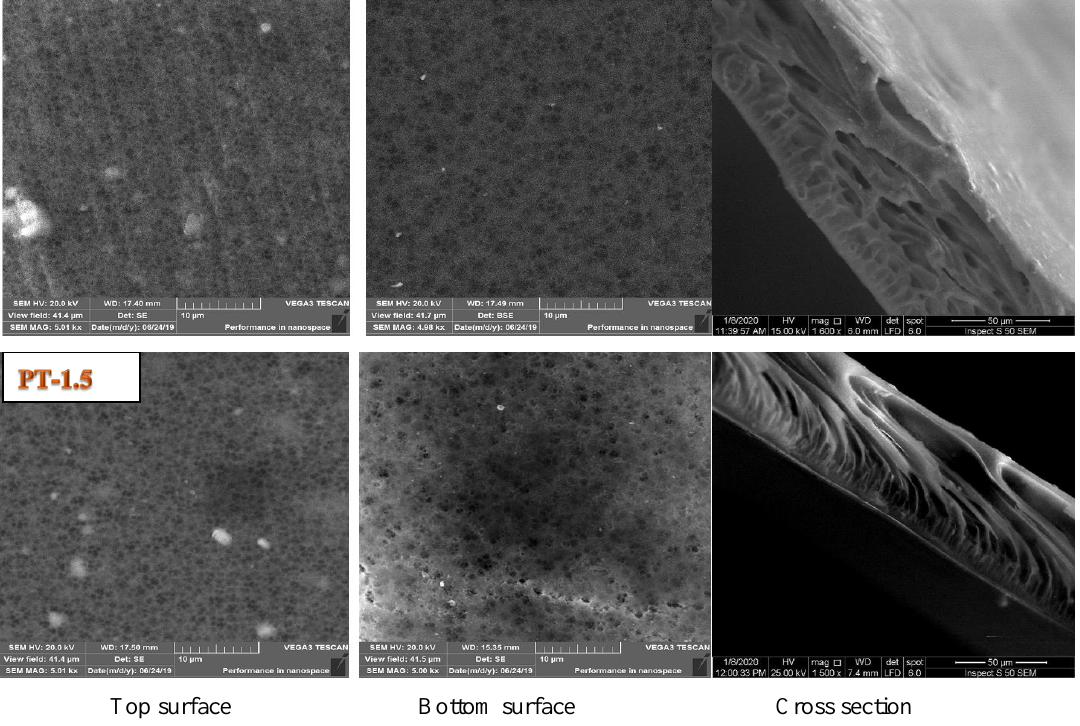
Top surface Bottom surface Cross section Figure 6. Scanning electron microscope (SEM) images of the cross-section and top and bottom surfaces of the PVC membranes at different TiO 2 amounts: ( PT-0 ) 0 gm TiO 2 ; ( PT-0.5 ) 0.5 gm TiO 2 ; ( PT-1 ) 1 gm TiO 2 ; and ( PT-1.5 ) 1.5 gm TiO 2 .